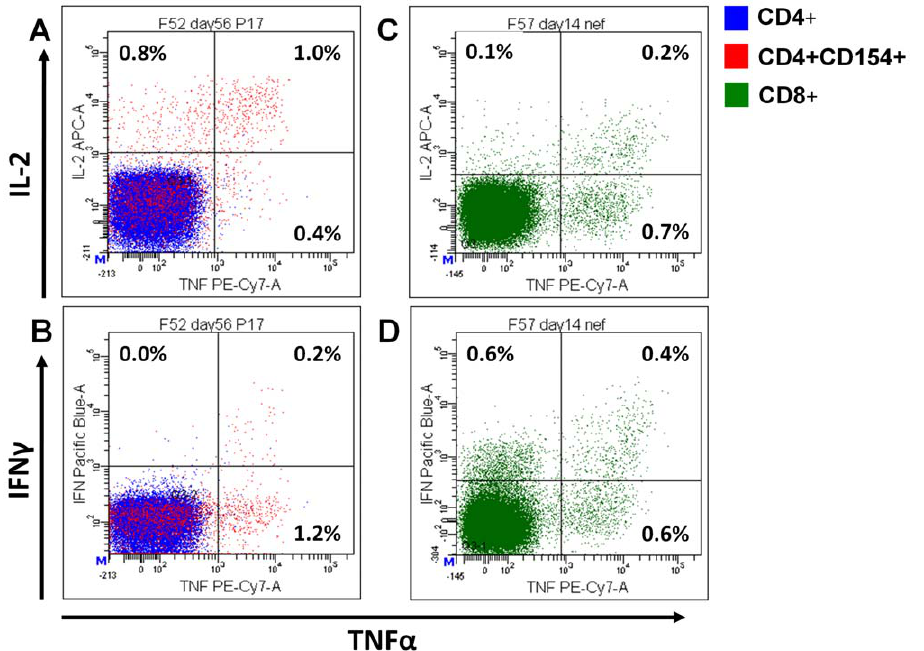
Figure 2. Macaque intracellular cytokine staining. Representative dot plots gated on CD4 + (A and B) and CD8 + (C and D) T cells from MV1-F4 immunised macaques F52 and F57, respectively. PBMC were stimulated overnight with p17 (A and B) or Nef (C and D) peptide pools. Blue events represent CD4 + and red CD4 + CD154 + T cells (A and B). Green events represent CD8 + T cells (C and D). Intracellular cytokine staining for TNF a versus IL-2 (A and C) and TNF a versus IFN c (B and D) is shown. Percentages shown represent the proportion of events in respective quadrants.